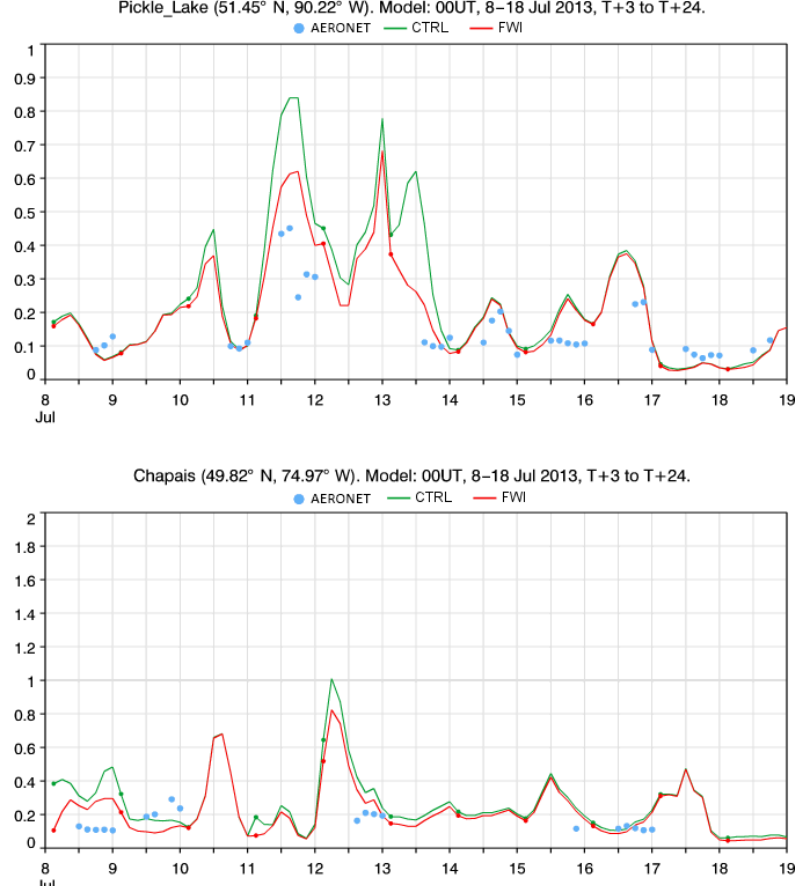
Figure 7. Local verification against observations. AOD at 550nm evolution at two AERONET stations (Pickle Lake and Chapais), which are in the proximity of Hudson Bay. Local measurements are compared to the two models’ simulations nearest grid point. The model simulations are a concatenation of 24h forecasts. The start of the forecast is marked with a dot.